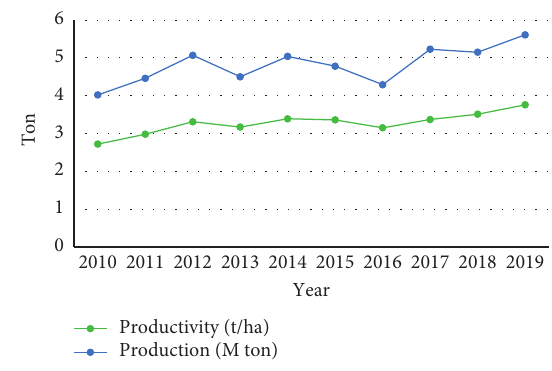
Figure 1: Production and productivity of rice in Nepal from 2010 to 2019